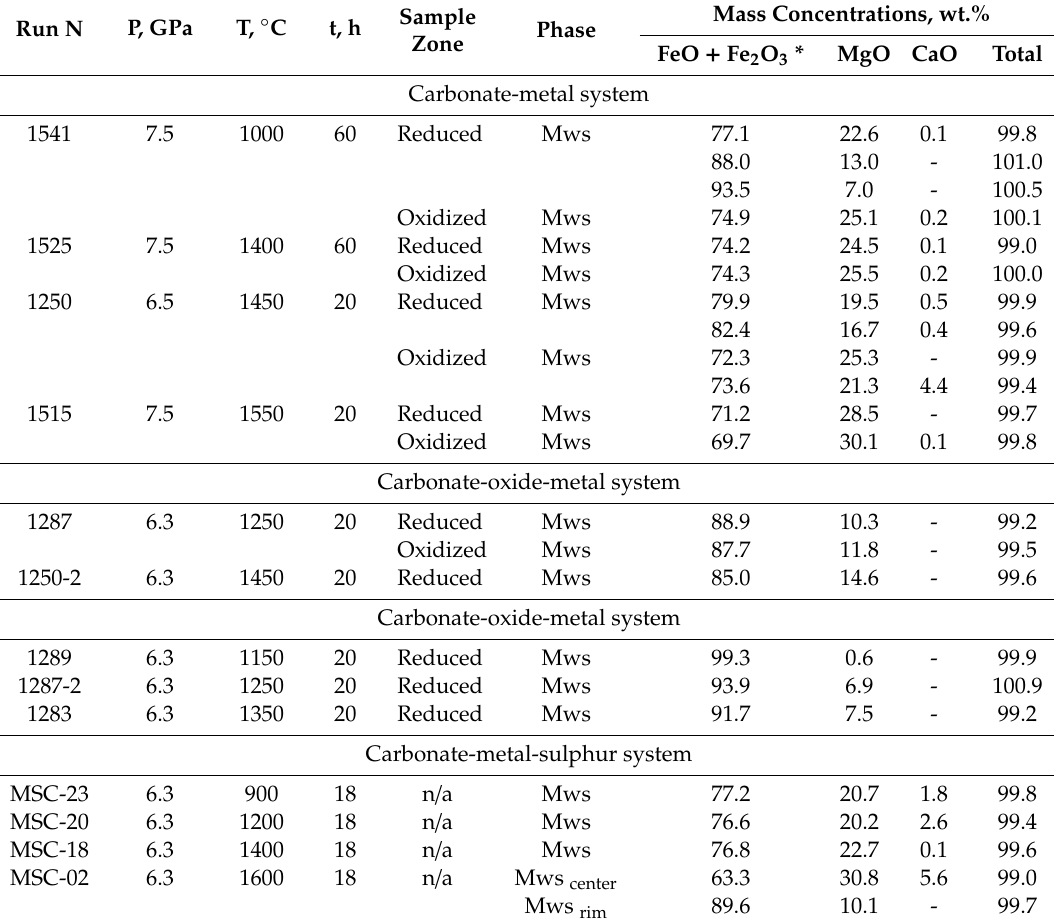
Table 2. Representative composition of magnesiowüstite according to the microprobe